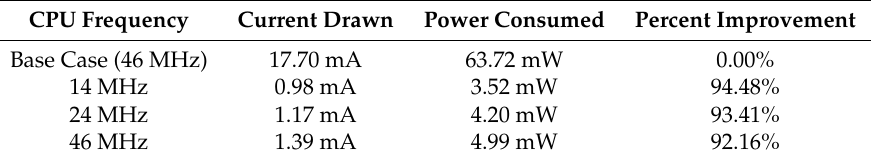
Table 4. BLE optimized power performance.